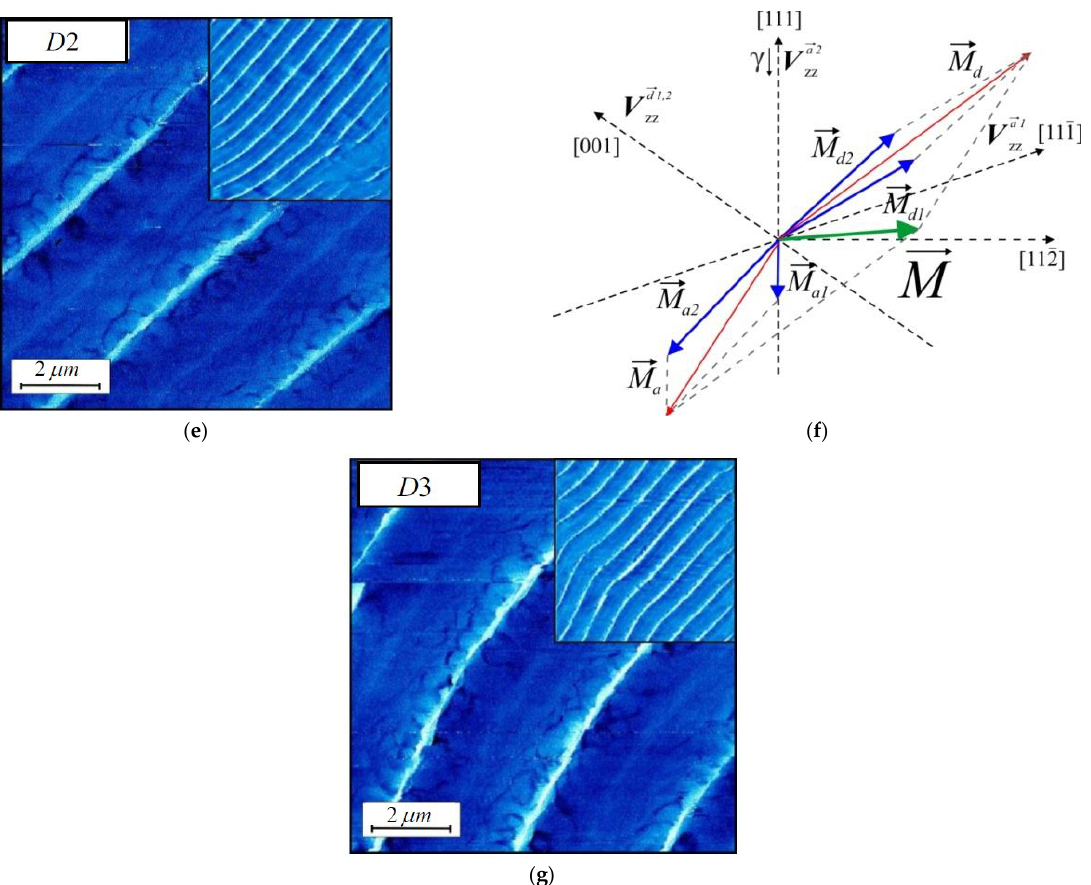
Figure 6. MFM images of the band domain structure ( a , c , e , g ) and the corresponding diagrams of spatial orientations of magnetic moments ( b , d , f ) of Ne + -implanted YIG film ( E = 82 keV) with doses of 0 сm −2 , 1 × 10 14 сm −2 , 2 × 10 14 сm −2 and 4 × 10 14 сm −2 (samples D0, D1, D2 and D3, respectively).